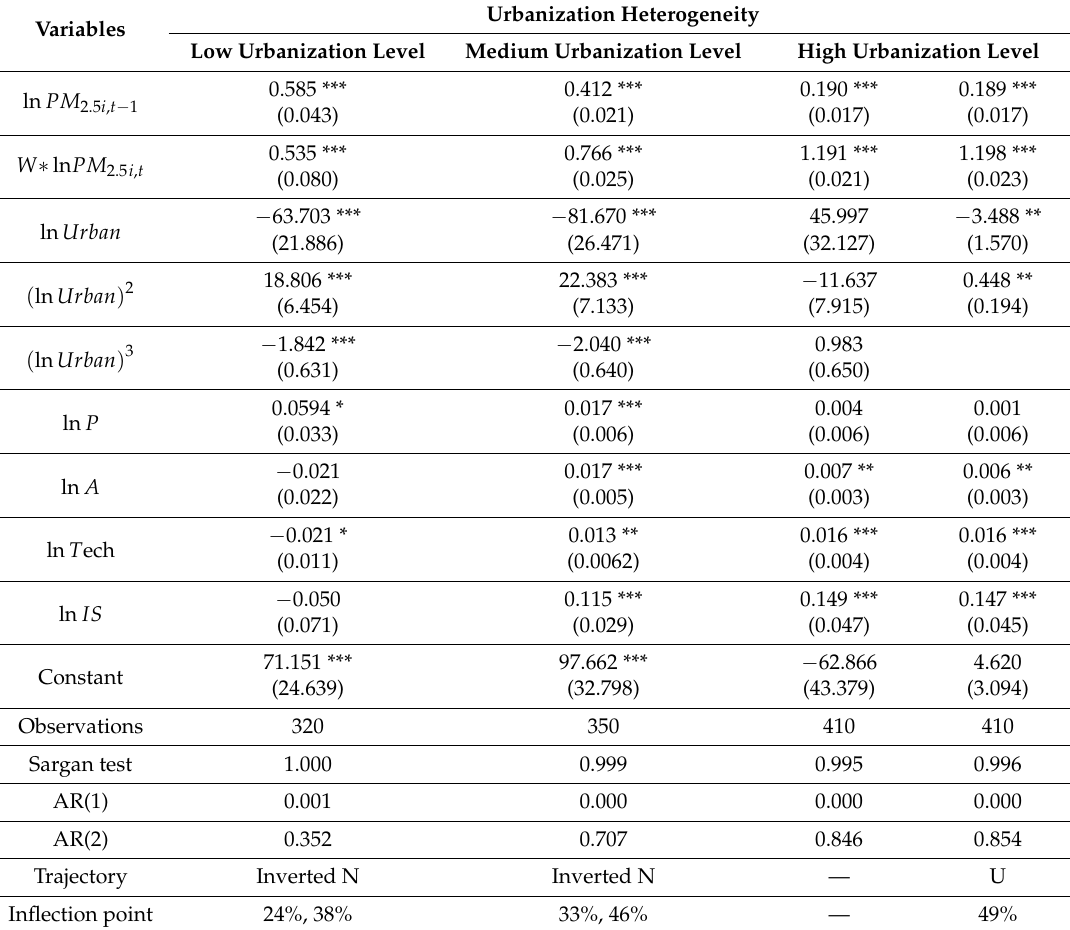
Table 5. Heterogeneity results according to cities on different population urbanization levels.